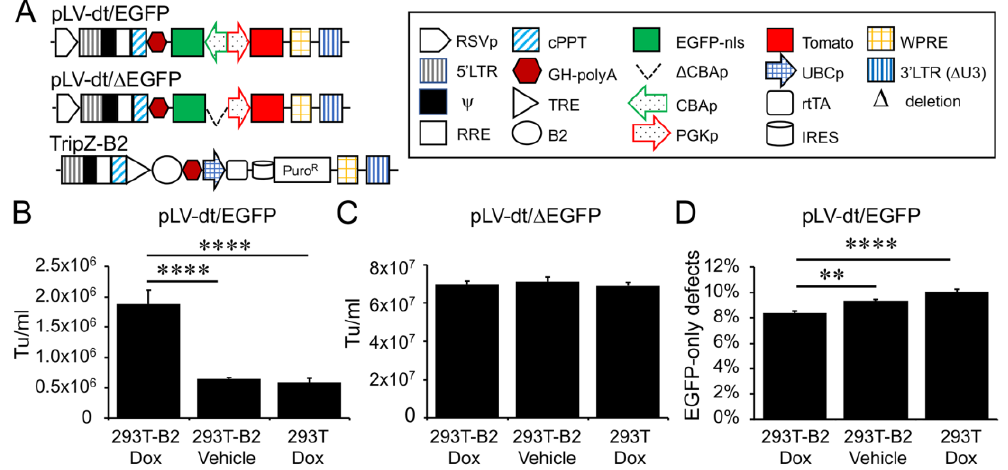
Figure 2. Suppressor of RNAi B2 protein increases titer and viral genome integrity of lentiviral vectors harboring bidirectional gene expression cassettes. ( A ) pLV-dt / ∆ EGFP and pLV-dt / EGFP are the proviral vector plasmids used in production of these lentiviral vectors. TripZ-B2 is a lentiviral vector used to make the 293T-B2 cell line that expresses B2 following doxycycline treatment. The box legend to the right highlights the components of these proviral plasmids. Definitions are as follows: 5’LTR, 5’ long terminal repeat; ψ , psi, viral packaging signal sequence; RRE, rev response element, where Rev protein binds; cPPT, central polypurine tract, recognition site for proviral DNA synthesis; STOP, translation stop sequence; EGFP-nls, EGFP with nuclear localization signal; ∆ CBAp, deletion of chicken beta-actin promoter (CBA); CBAp, CBA promoter in reverse orientation to the viral genomic transcript; PGKp, mouse phosphoglycerate kinase 1 promoter; TRE, tetracycline response element; UBCp, ubiquitin C promoter; rtTA, reverse tetracycline trans-activator; IRES, internal ribosomal entry site; WPRE, Woodchuck hepatitis virus post-transcriptional regulatory element for increasing nuclear export; 3’LTR ( ∆ U3), 3’ long terminal repeat with deletion in unique 3’ sequence that is necessary for activating viral genome transcription. ( B ) Comparison of LV-dt / EGFP titers produced by 293T-B2 with doxycycline treatment, 293T-B2 with vehicle treatment, and 293T with doxycycline treatment. Data show the mean +/ -SEM for N = 6 viral preparations. ( C ) Comparison of lentiviral vector LV-dt / ∆ EGFP transduction unit per milliliter (Tu / mL) produced by 293T-B2 with doxycycline treatment, 293T-B2 with vehicle (water) treatment, and 293T with doxycycline treatment. Data show the mean +/ -SEM for N = 6 viral preparations. ( D ) Comparison of the percentage of cells positive for EGFP only among LV-dt / EGFP infected cells produced by 293T-B2 with doxycycline treatment, 293T-B2 with vehicle treatment, and 293T with doxycycline treatment. Data show the mean +/ -SEM for N = 6 viral preparations. ( B,C ) Statistical comparisons were made by one-way ANOVA, Bonferroni’s multiple comparison test. ****, p < 0.0001. **, p < 0.01.